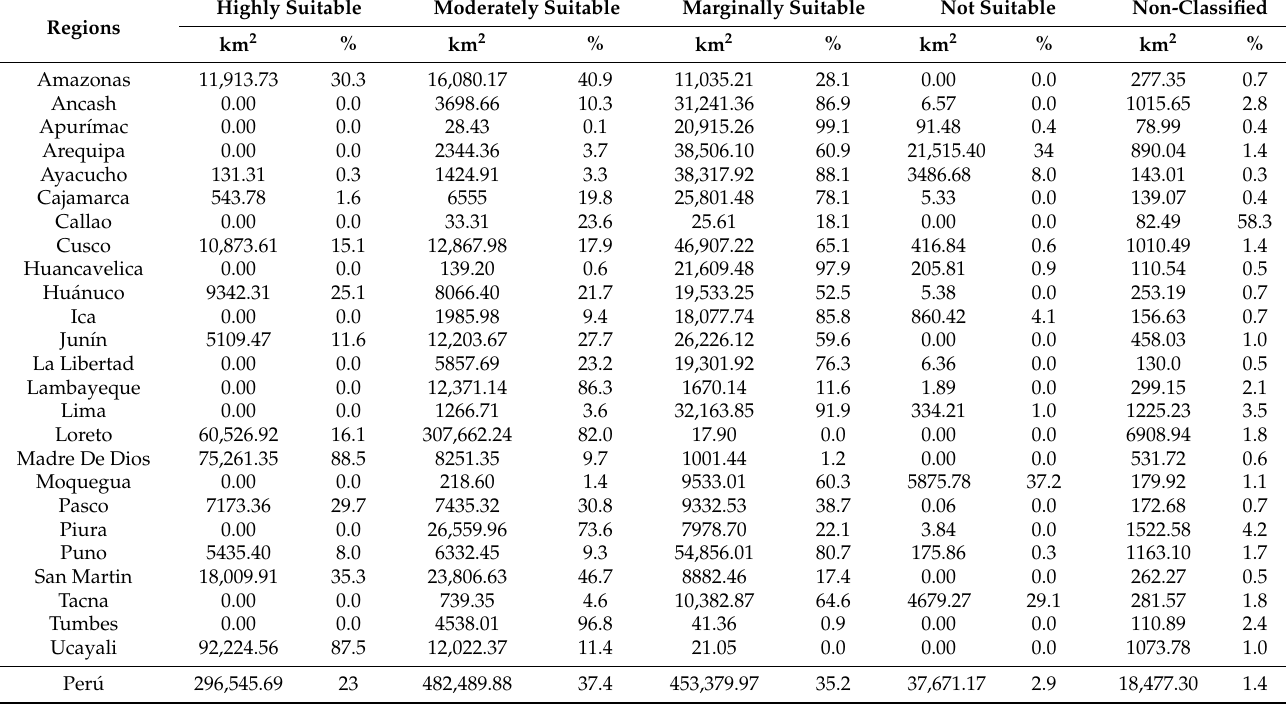
Table A4. Land suitability for cocoa cultivation in Peruvian regions, AHP–MaxEnt model.